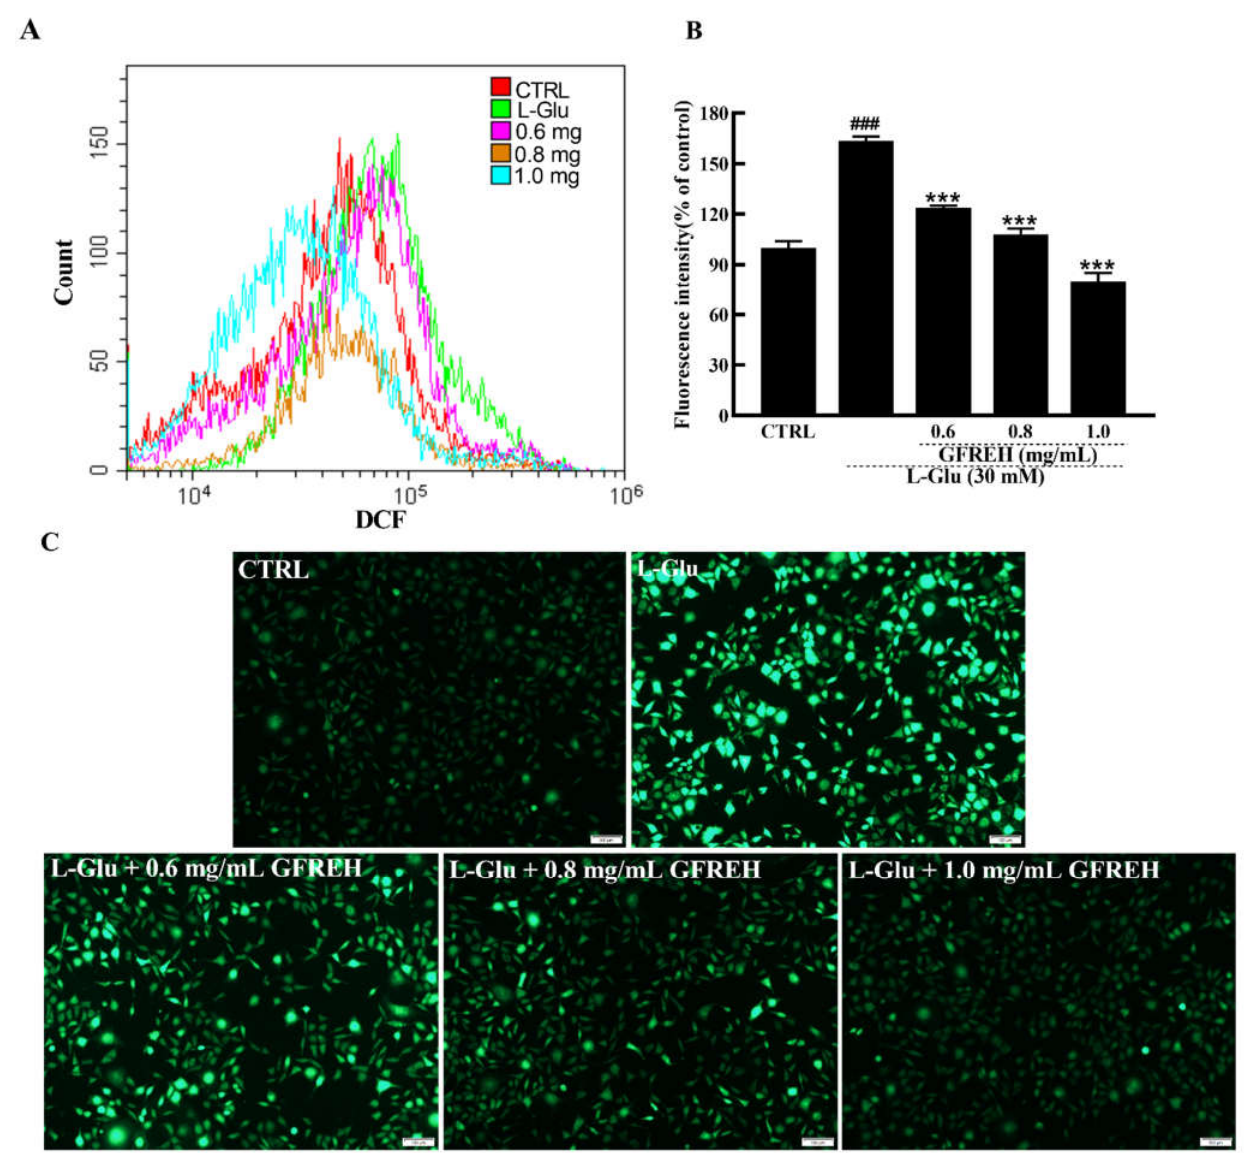
Figure 6. ROS are detected by DCFH-DA, which produces green fluorescence in the presence of ROS. ( A ) ROS contents in SH-SY5Y cells detected by a flow cytometer. ( B ) Cartogram of ROS in SH-SY5Y cells under different treatments, (n = 3). The data are expressed as the mean value ± SD. ### p < 0.001 vs. CTRL, *** p < 0.001 vs. L-Glu-treated cells. ( C ) Pictures of SH-SY5Y cells are imaged by fluorescence microscopy. Scale bar is 100 μm.